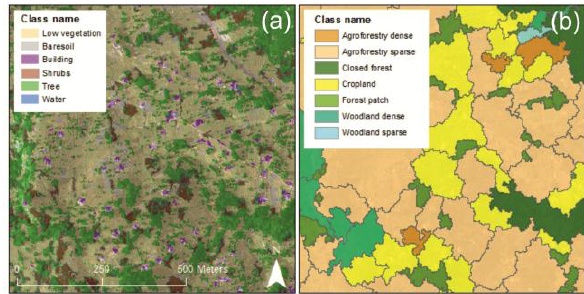
Figure 4. Example of the level-1 classification (a) and level-0 classification based on the fractional cover of level-1 classes